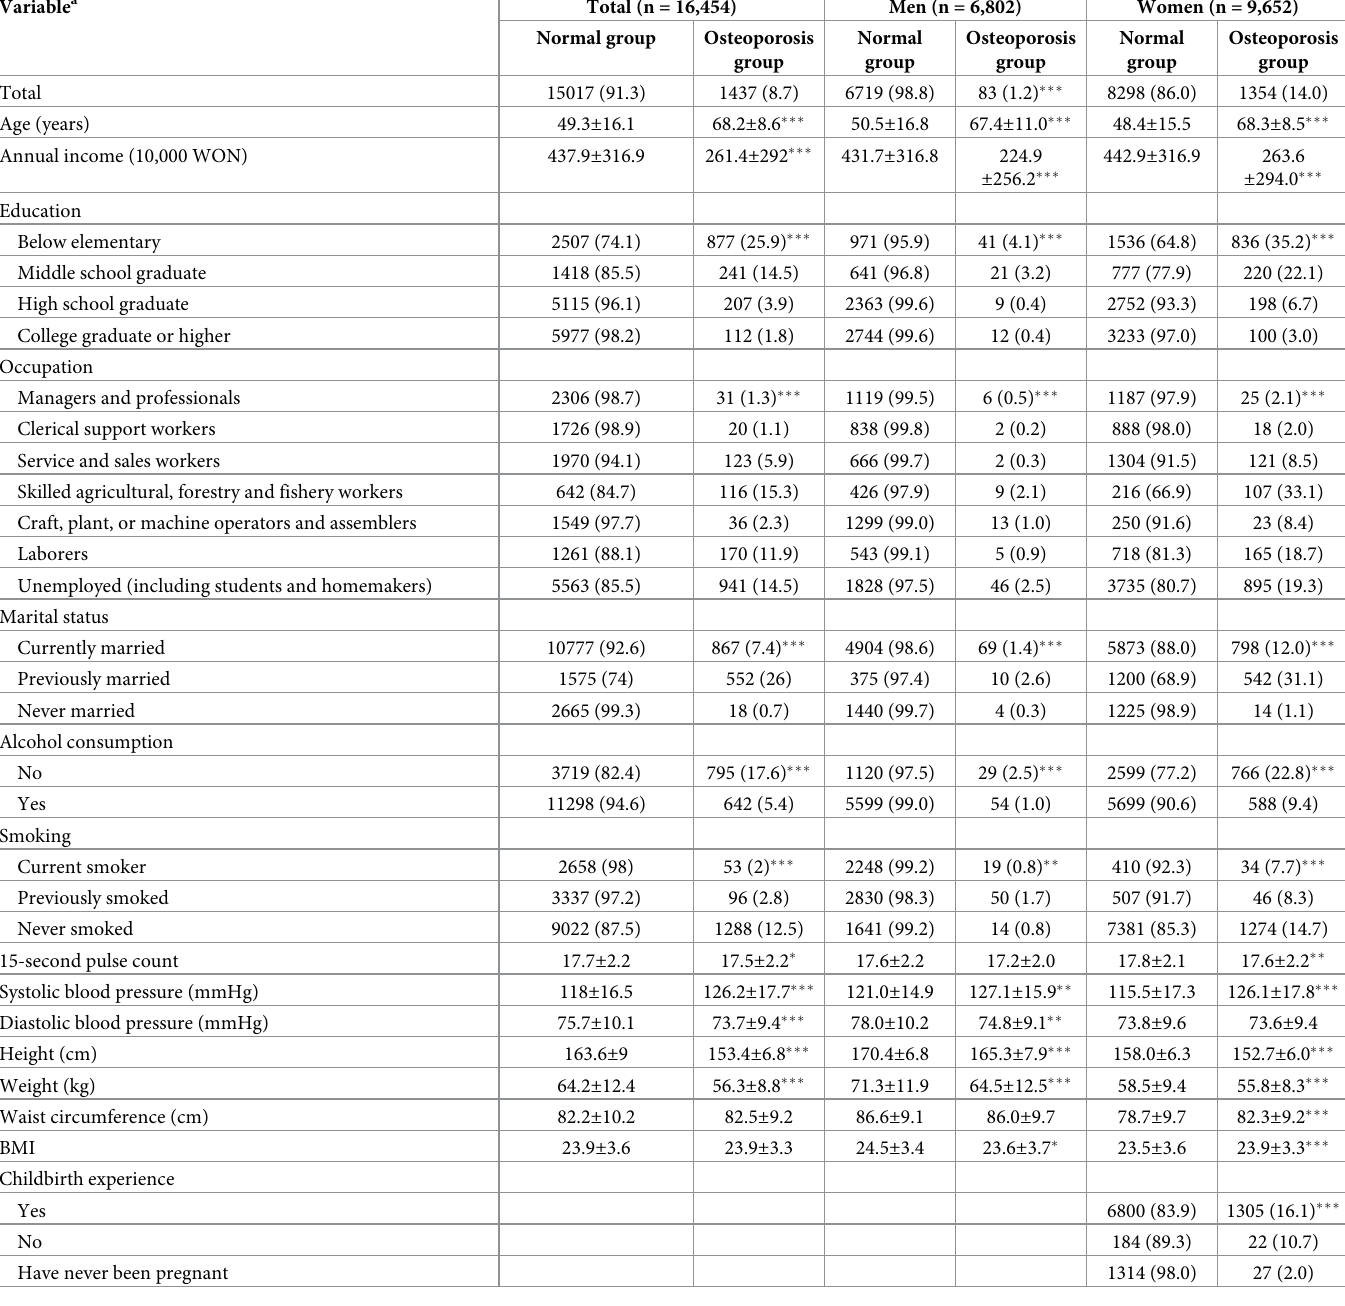
Table 2. Characteristics of the study